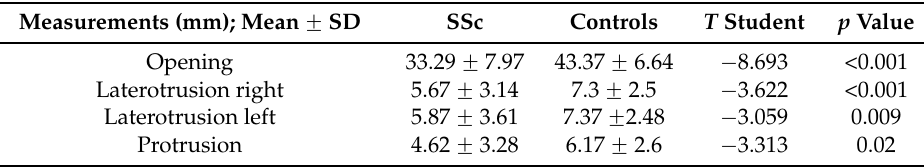
Table 8. Restricted Movements